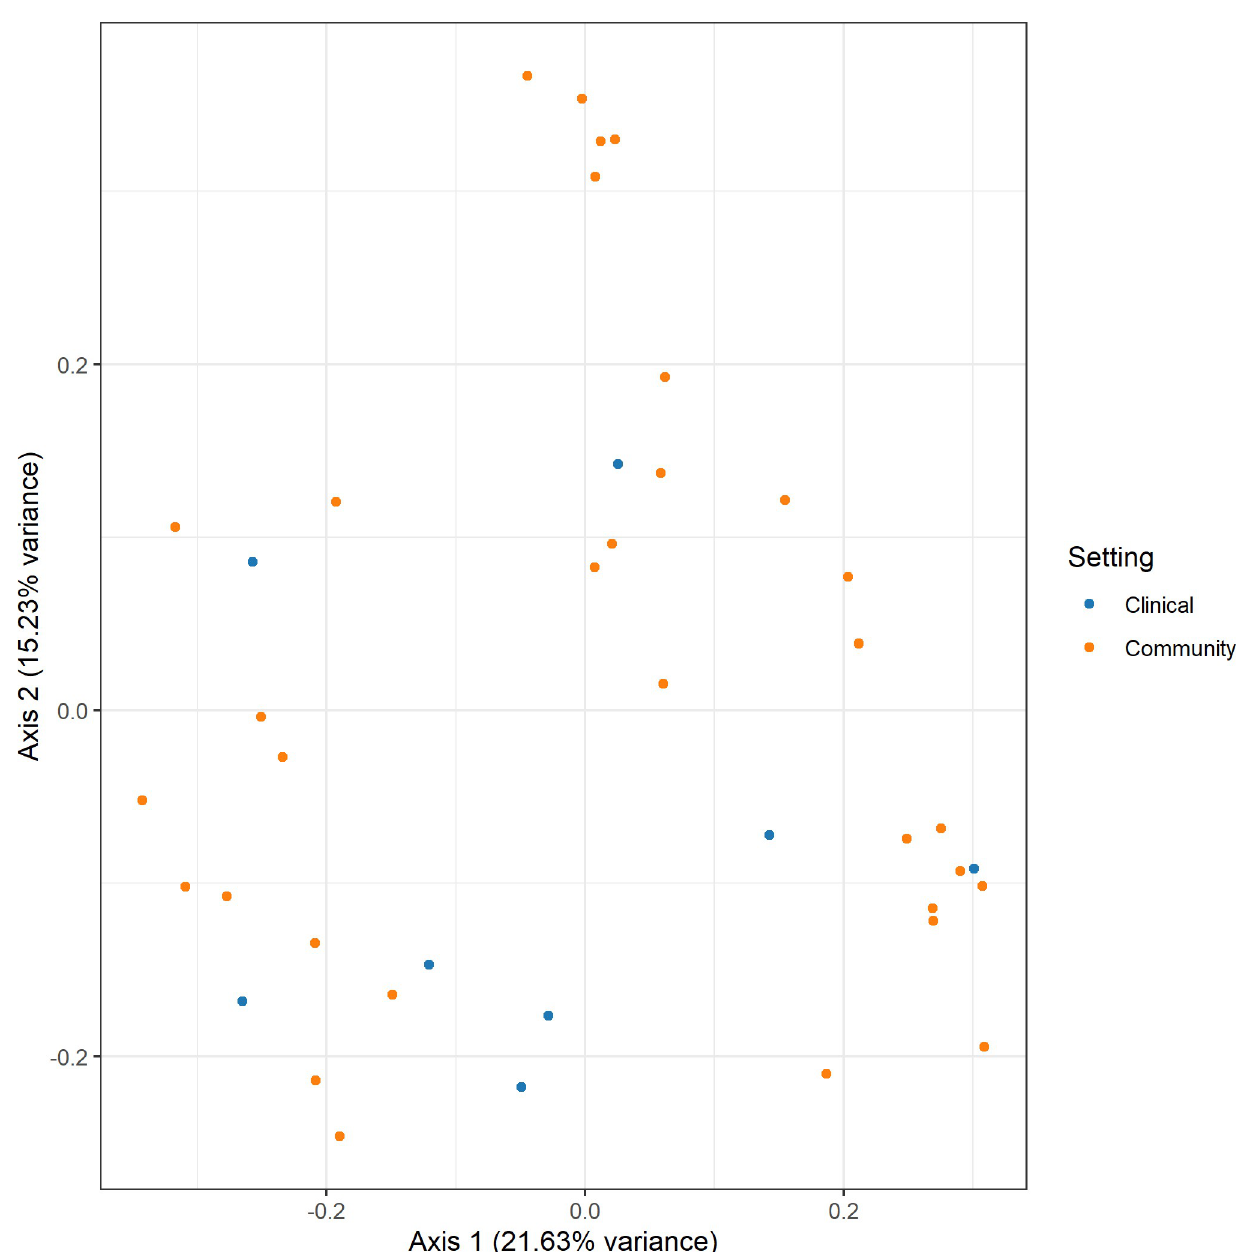
Fig 5. Principal coordinate analysis with Jaccard distance based on the isolates’ antibiotic resistance genes, susceptibility profiles, and carried plasmid groups.